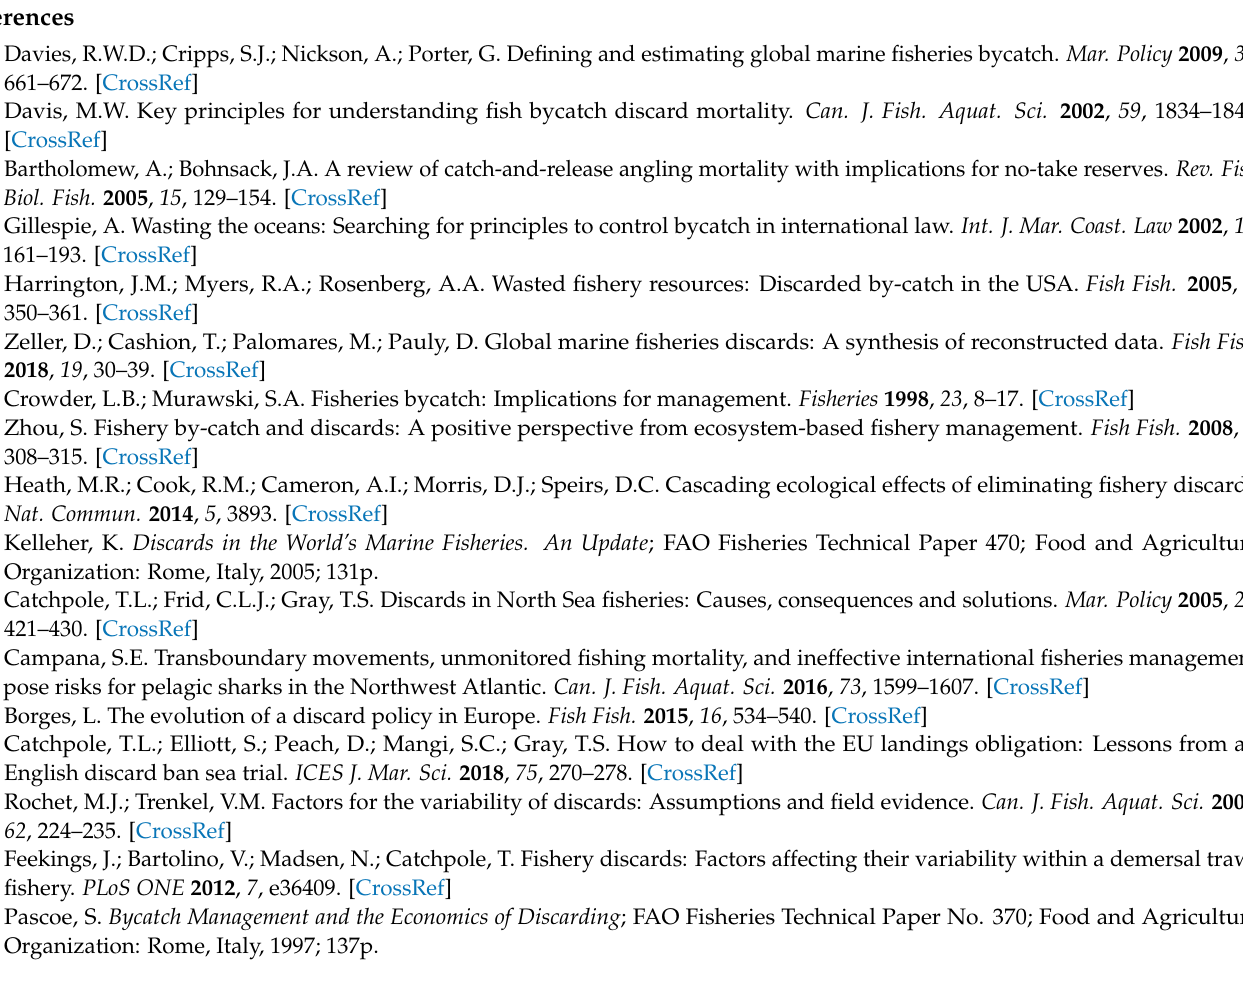
models, Figure S3: Fits to length compositions of discards, Figure S4: Pearson residuals for fits to length compositions of discards, Figure S5: Fits to age compositions of landings, Figure S6: Pearson residuals for fits to age compositions of landings, Figure S7: Fits to fishery dependent indices of abundance, Figure S8: Pearson residuals for fits to length compositions from fishery independent surveys, Figure S9: Fits to fishery independent indices of abundance, Figures S10 and S11: Estimated selectivity patterns, Figure S12: Estimated time-varying retention patterns, Table S1: Negative log-likelihood values of model